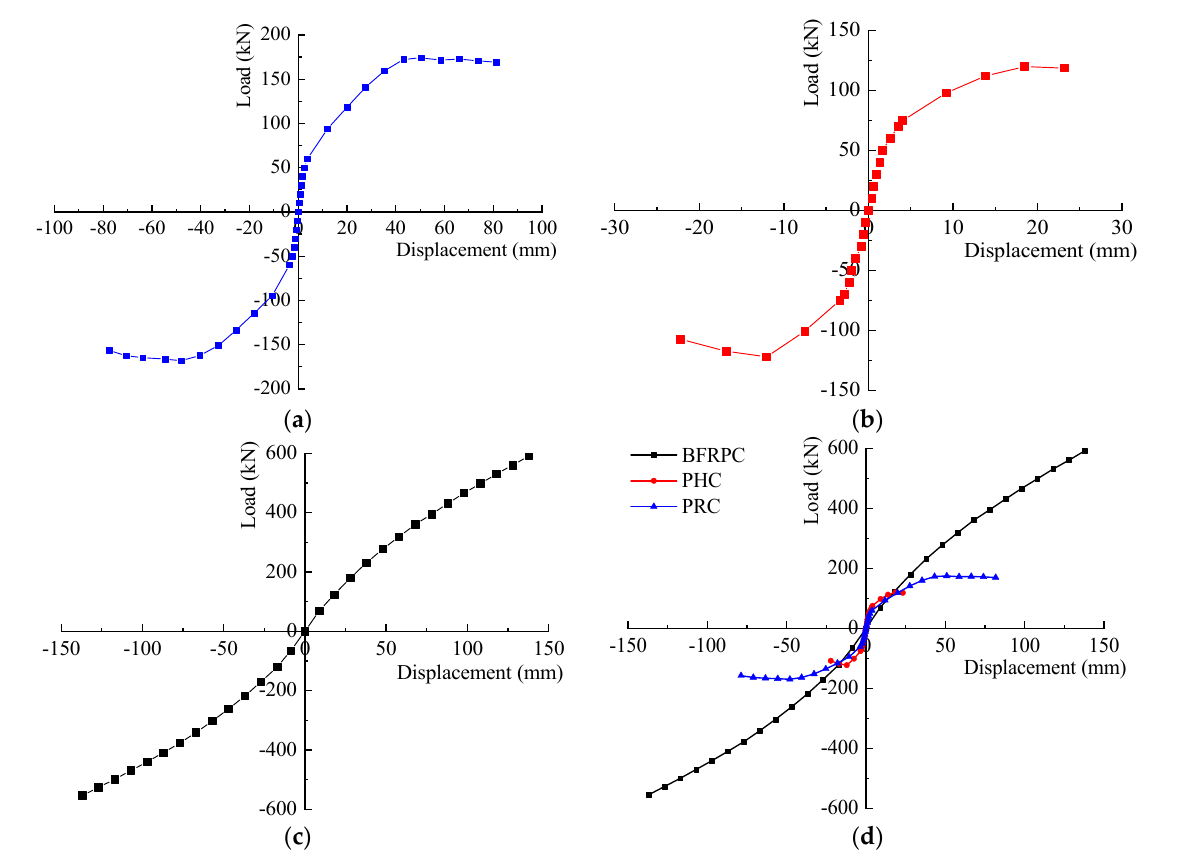
Figure 11. The skeleton curve of each column specimen and the comparison curve: ( a ) PRC tube column; ( b ) PHC tube column; ( c ) BFRPC composite column; ( d ) comparison curve.